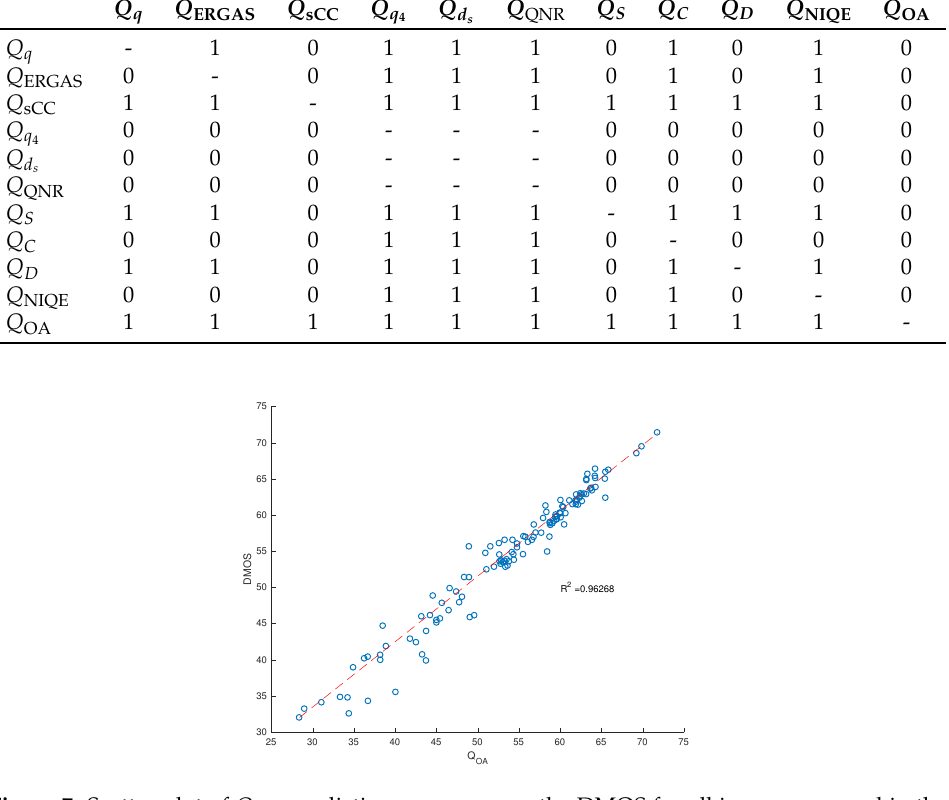
Figure 7. Scatter plot of Q OA prediction scores versus the DMOS for all images assessed in the subjective human study and the best fitting logistic function. Notice the linear relationship with R 2 =